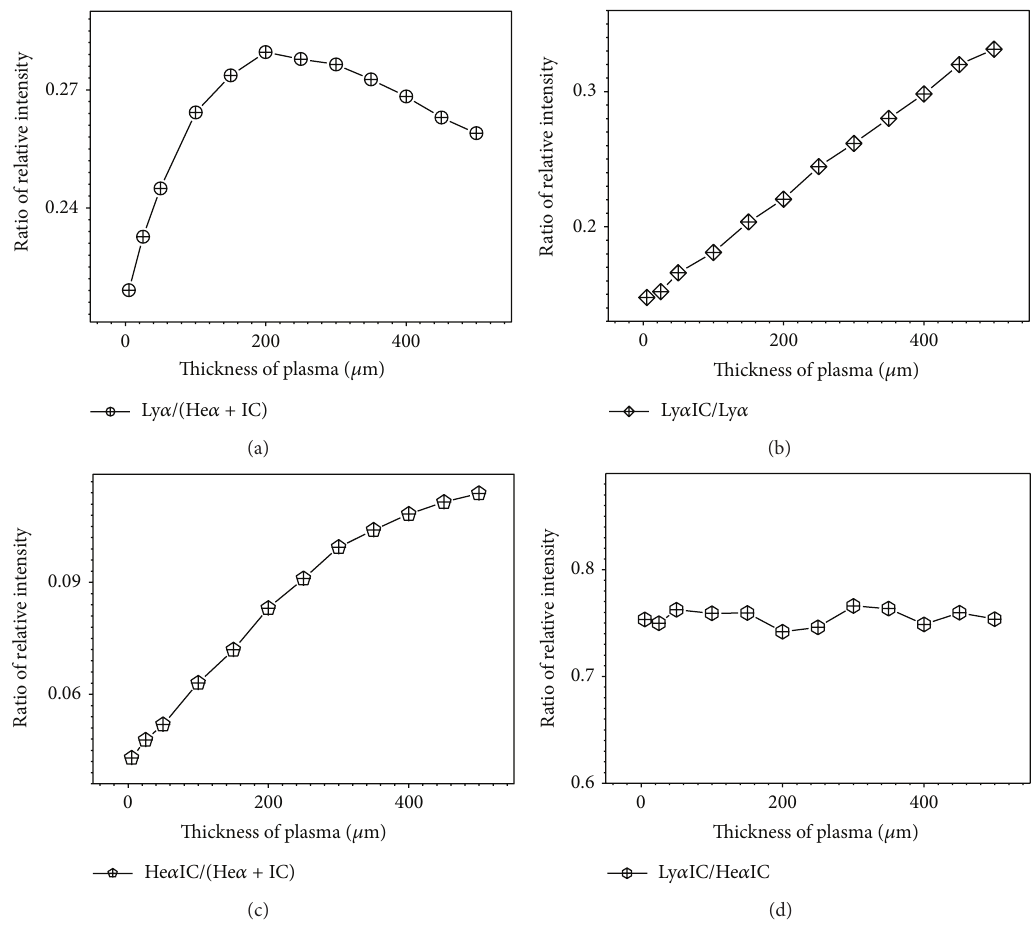
Figure 4: Radiation intensity ratio of different plasma at boundary